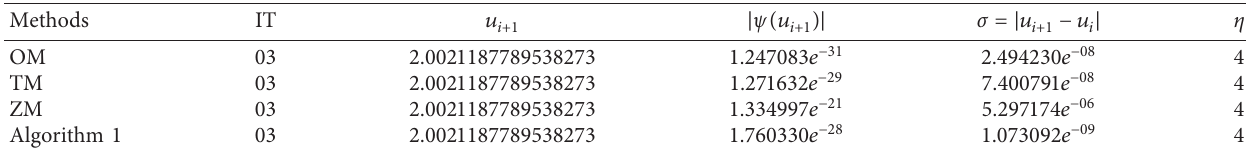
Table 5: Comparison of different fourth-order